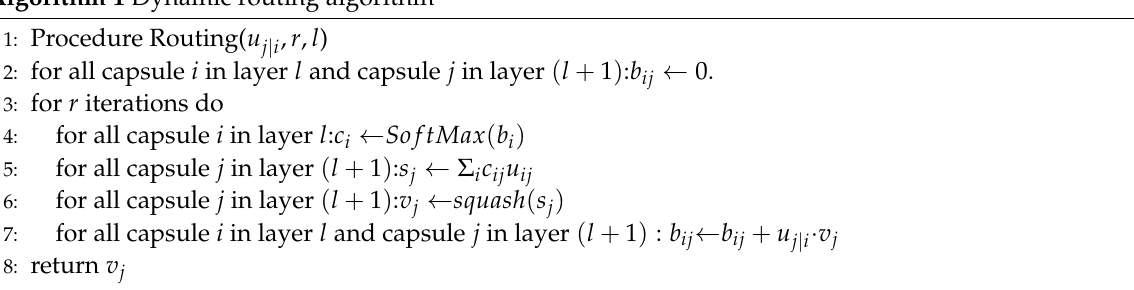
Algorithm 1 Dynamic routing algorithm